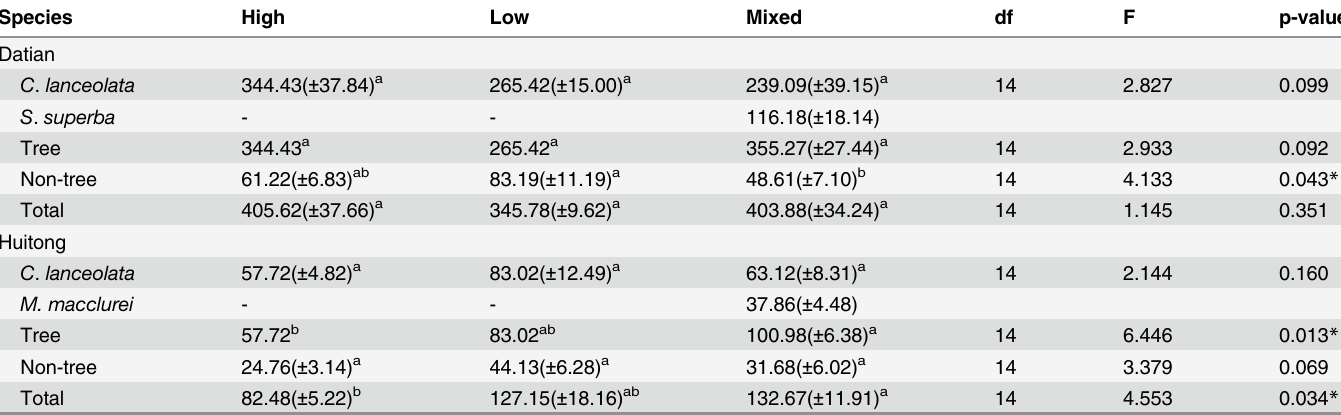
Table 5. Effects of stand type on the fine root biomass (g m -2 ) at 0 – 40 cm depth (mean ±